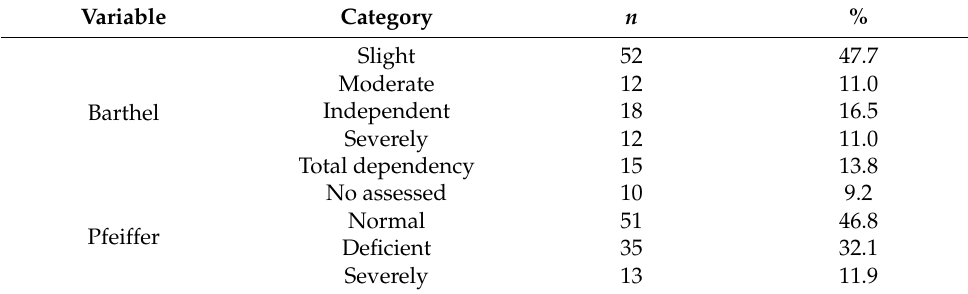
Table 2. Grouped descriptive of the Barthel and Pfeiffer table. n =